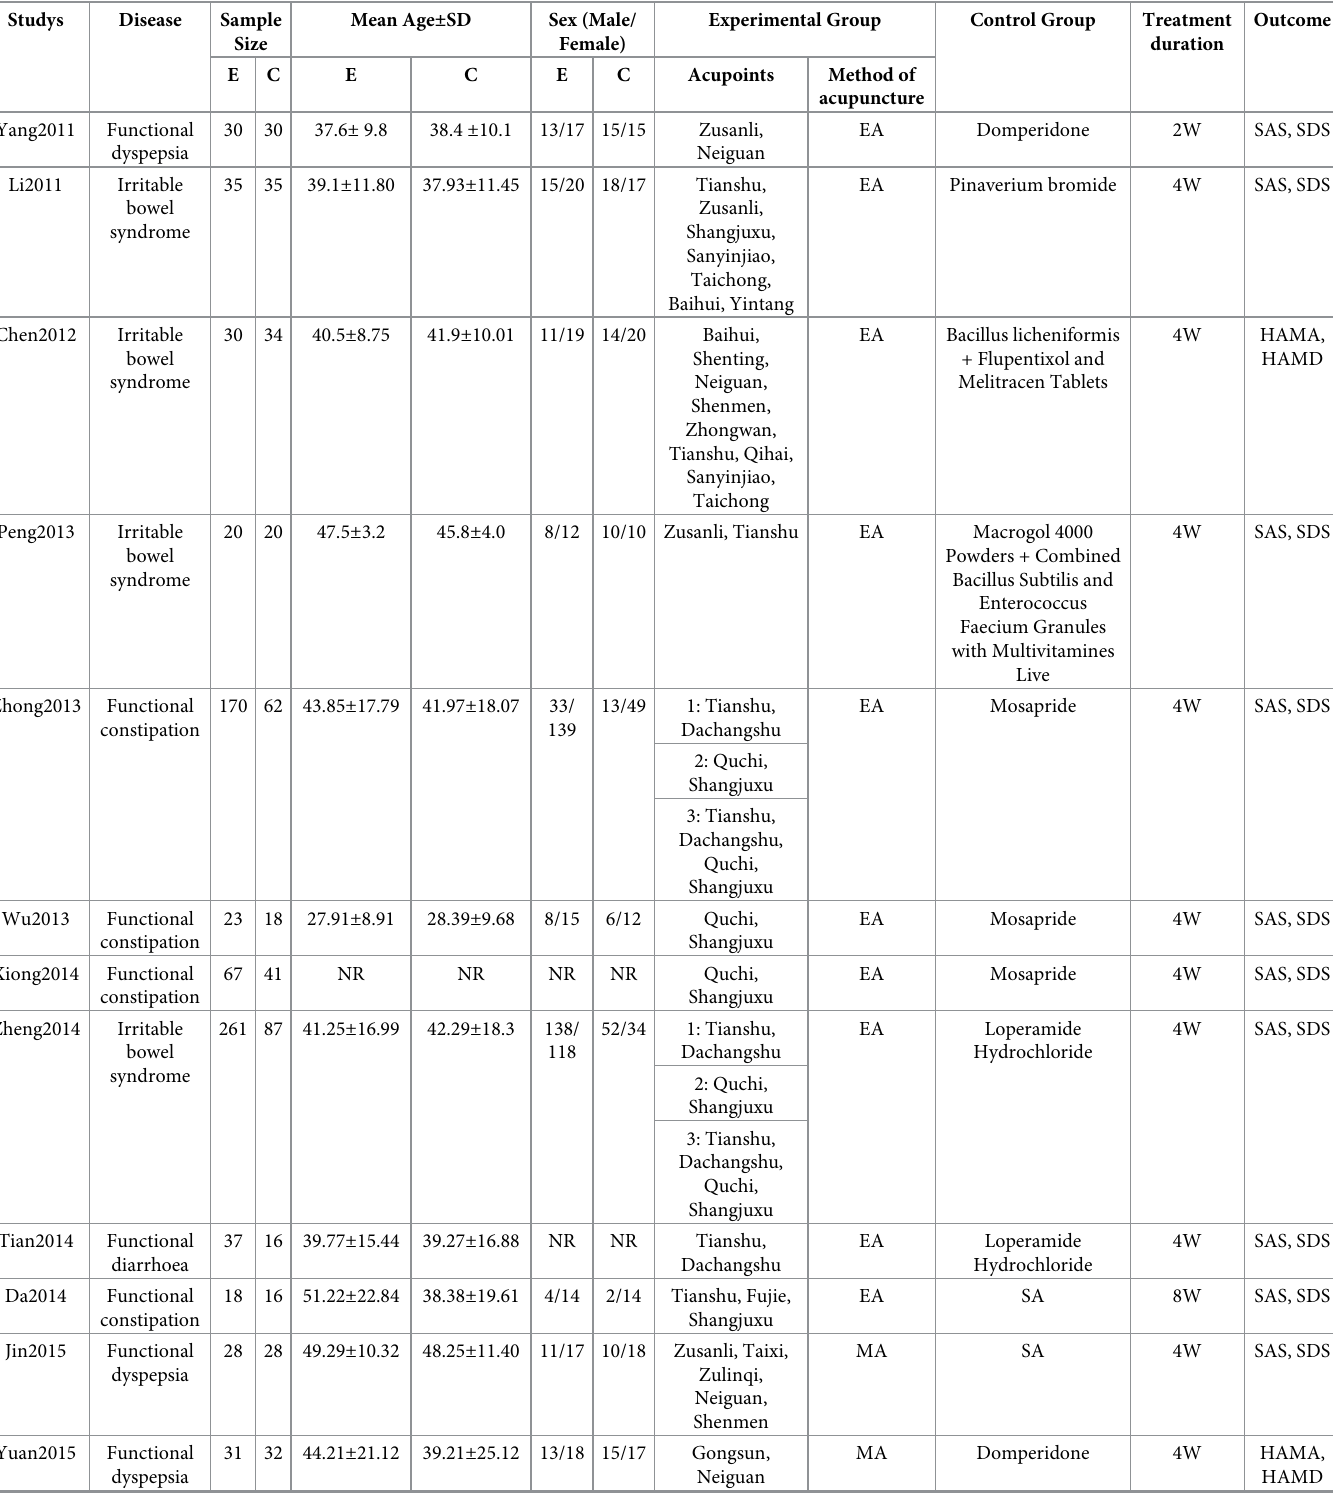
Table 1. Characteristics of the included